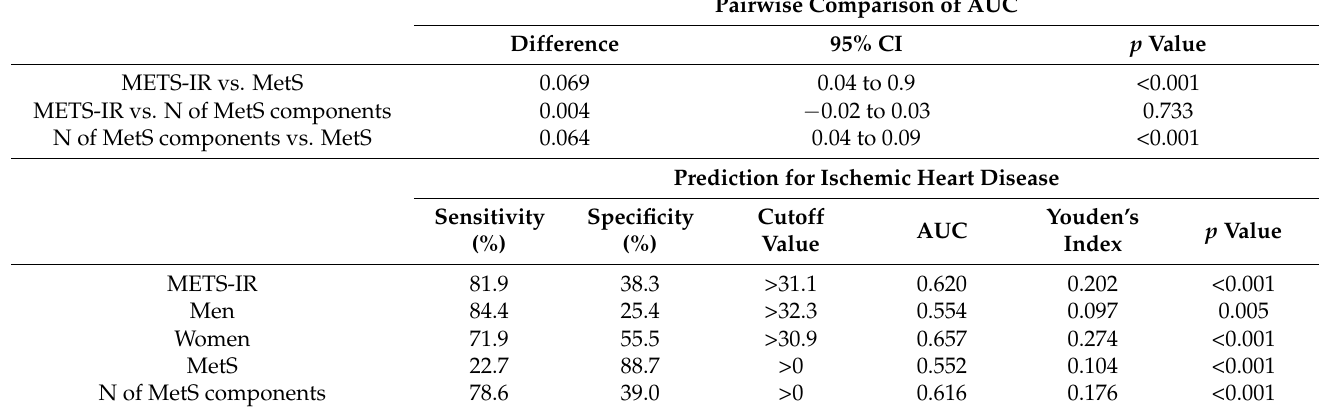
Table 3. METS-IR versus MetS and the number of MetS components for predicting IHD. Pairwise Comparison of